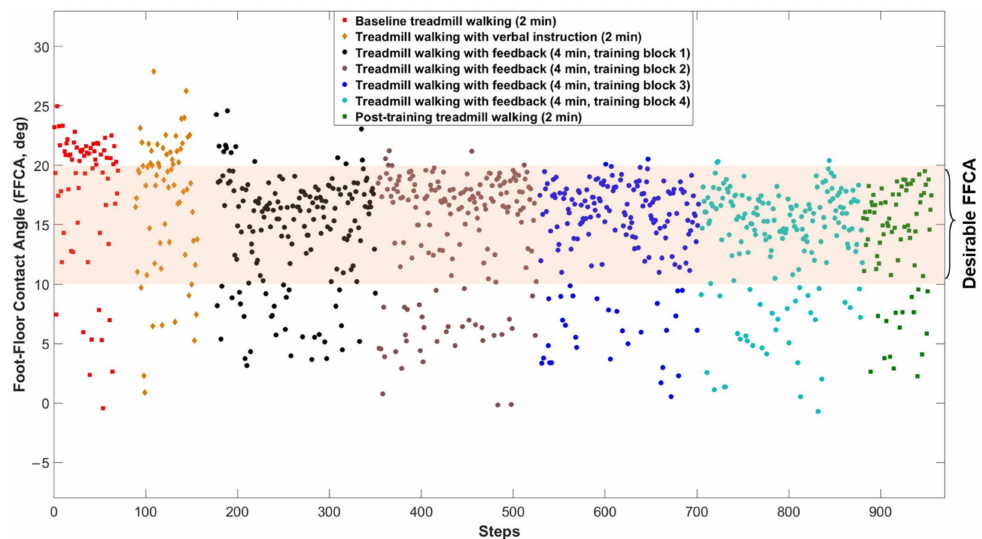
Figure 3. Example of the distribution of FFCAs for different treadmill walking conditions for a representative participant ( n = 1). Each dot represents the FFCA of one step detected by the IMU.